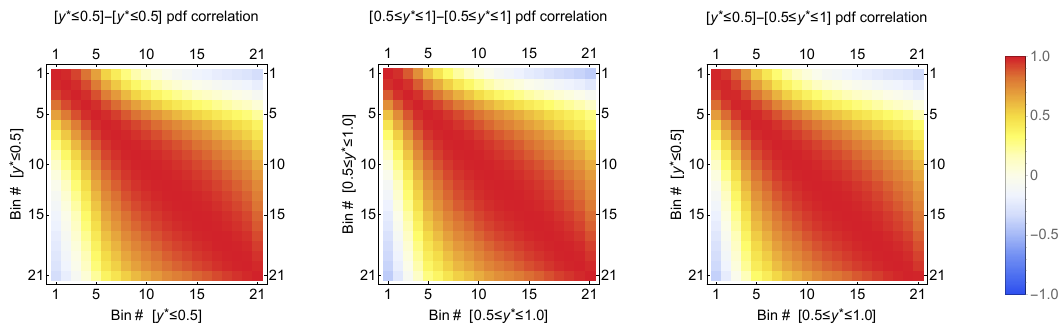
Figure 3 . PDF correlation (from the S no-jet set) for the 7 TeV ATLAS dijet analysis. We show the correlation among di(cid:11)erent invariant mass bins in the (cid:12)rst two rapidity bins ((cid:12)rst and second panel) and the cross correlation between the (cid:12)rst and second rapidity bin (third panel). Crucially, di(cid:11)erent rapidity bins with similar invariant mass have highly correlated PDF uncertainties. ref. [75] makes a similar observation, when (cid:12)tting the inclusive jet p distribution at 8